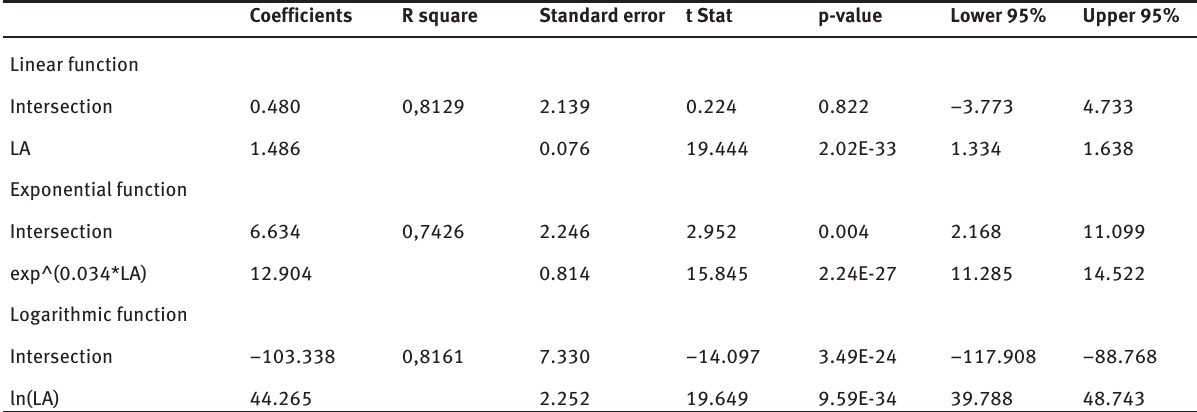
Table 3: Regression